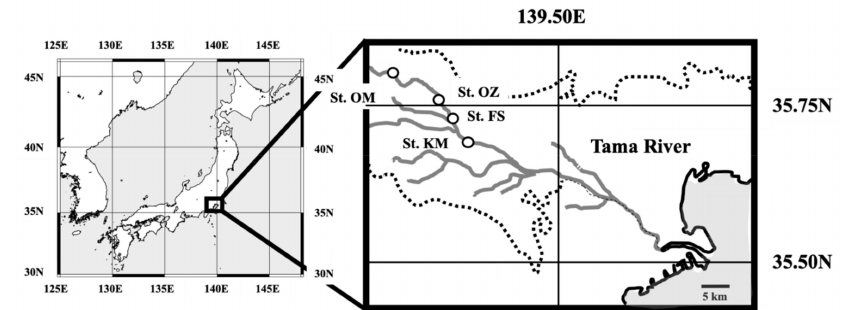
Figure 1. Map of the sampling sites in the present study. The left map indicates the map of Japan with the latitude and longitude, and the right map enclosed by bold square represents the study area. In the right map, the stations OM, OZ, FS and KM are located in Oume, Ozaku, Fussa and Komiya cities, respectively. The gray and thick line indicates Tama River. The solid and dot lines indicate the coastal line and prefecture’s border, respectively. Scale bar indicates 5